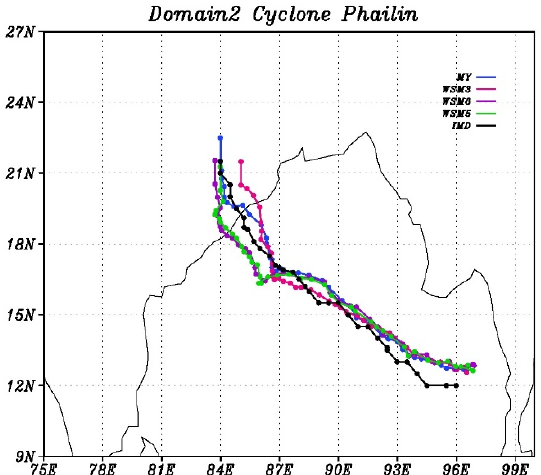
Figure 3. Model-simulated track positions of Phailin during 00 UTC, 08 October to 06 UTC, 13 October 2013 using 00 UTC, 08 October 2013 as initial conditions. The positions were identified through the minimum sea level pressure from different WRF experiments along with IMD observations.